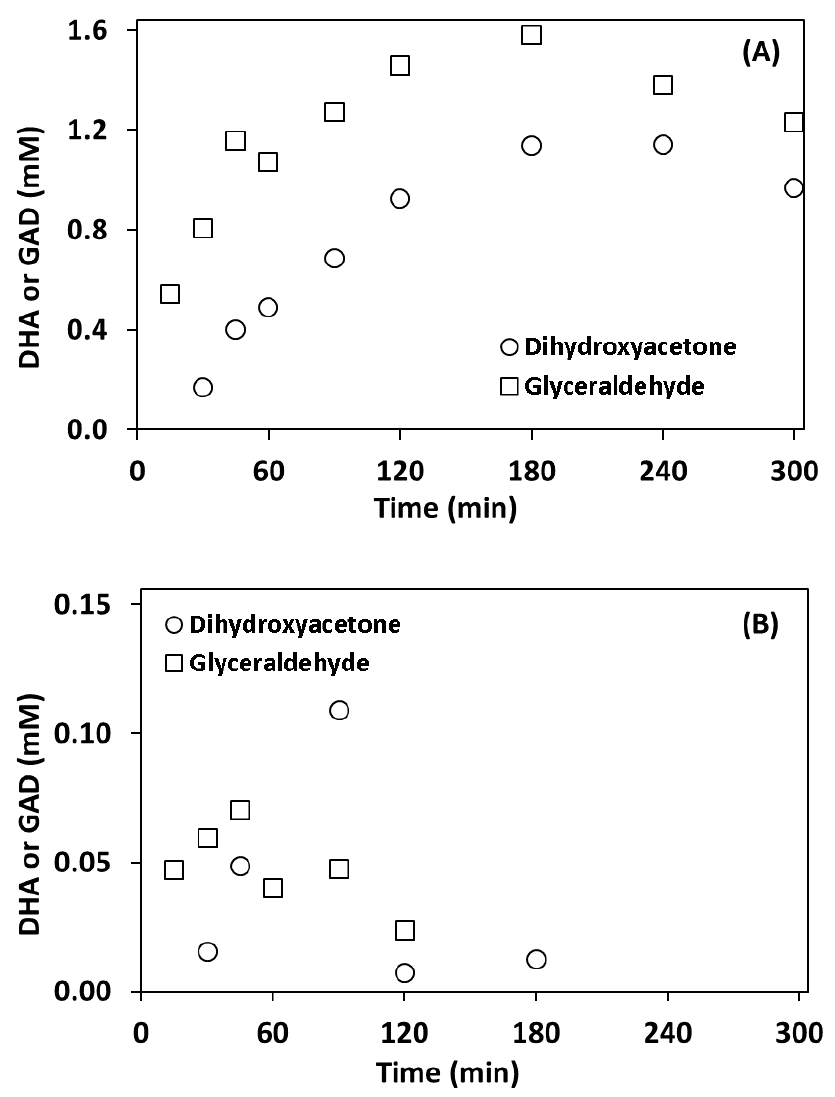
Figure 4. Effect of reduced photocatalyst loading on the concentration of DHA and GAD in the water phase: ( A ) glycerol loading of 0.4 mmol, and ( B ) glycerol loading of 0.04 mmol. Glycerol concentration